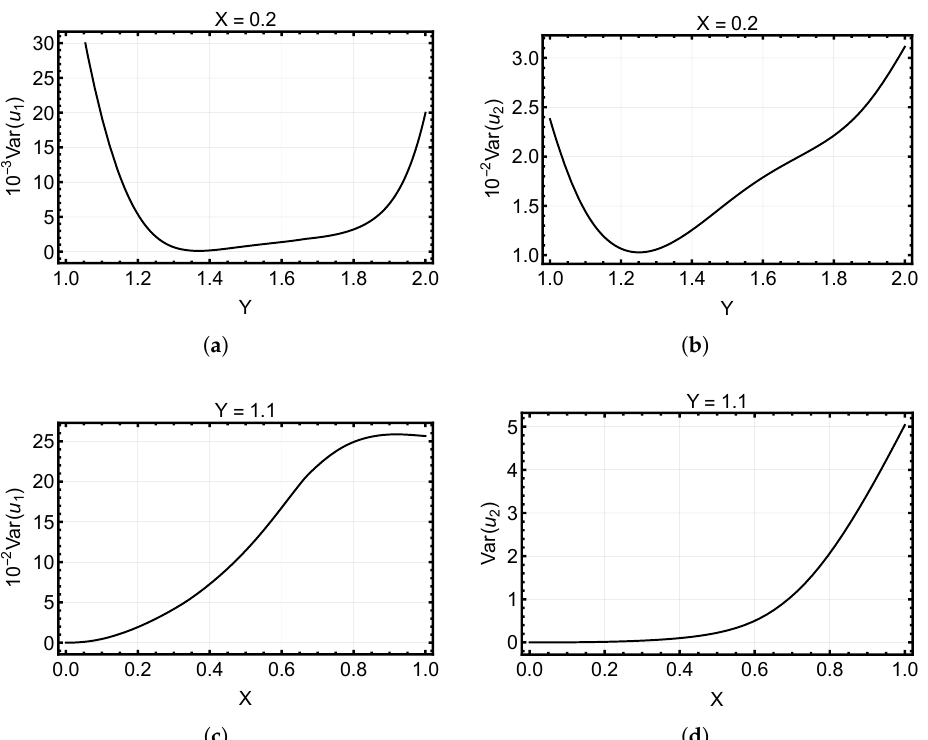
Figure 12. Eight regions of uncertain materials. Detail plots of the variance along cuts over the deterministic computational domain. Although there are jumps in the realizations of the random material field, the solution method is continuous. ( a ) Var ( u 1 ) , ( b ) Var ( u 2 ) , ( c ) Var ( u 1 ) , ( d ) Var ( u 2 )